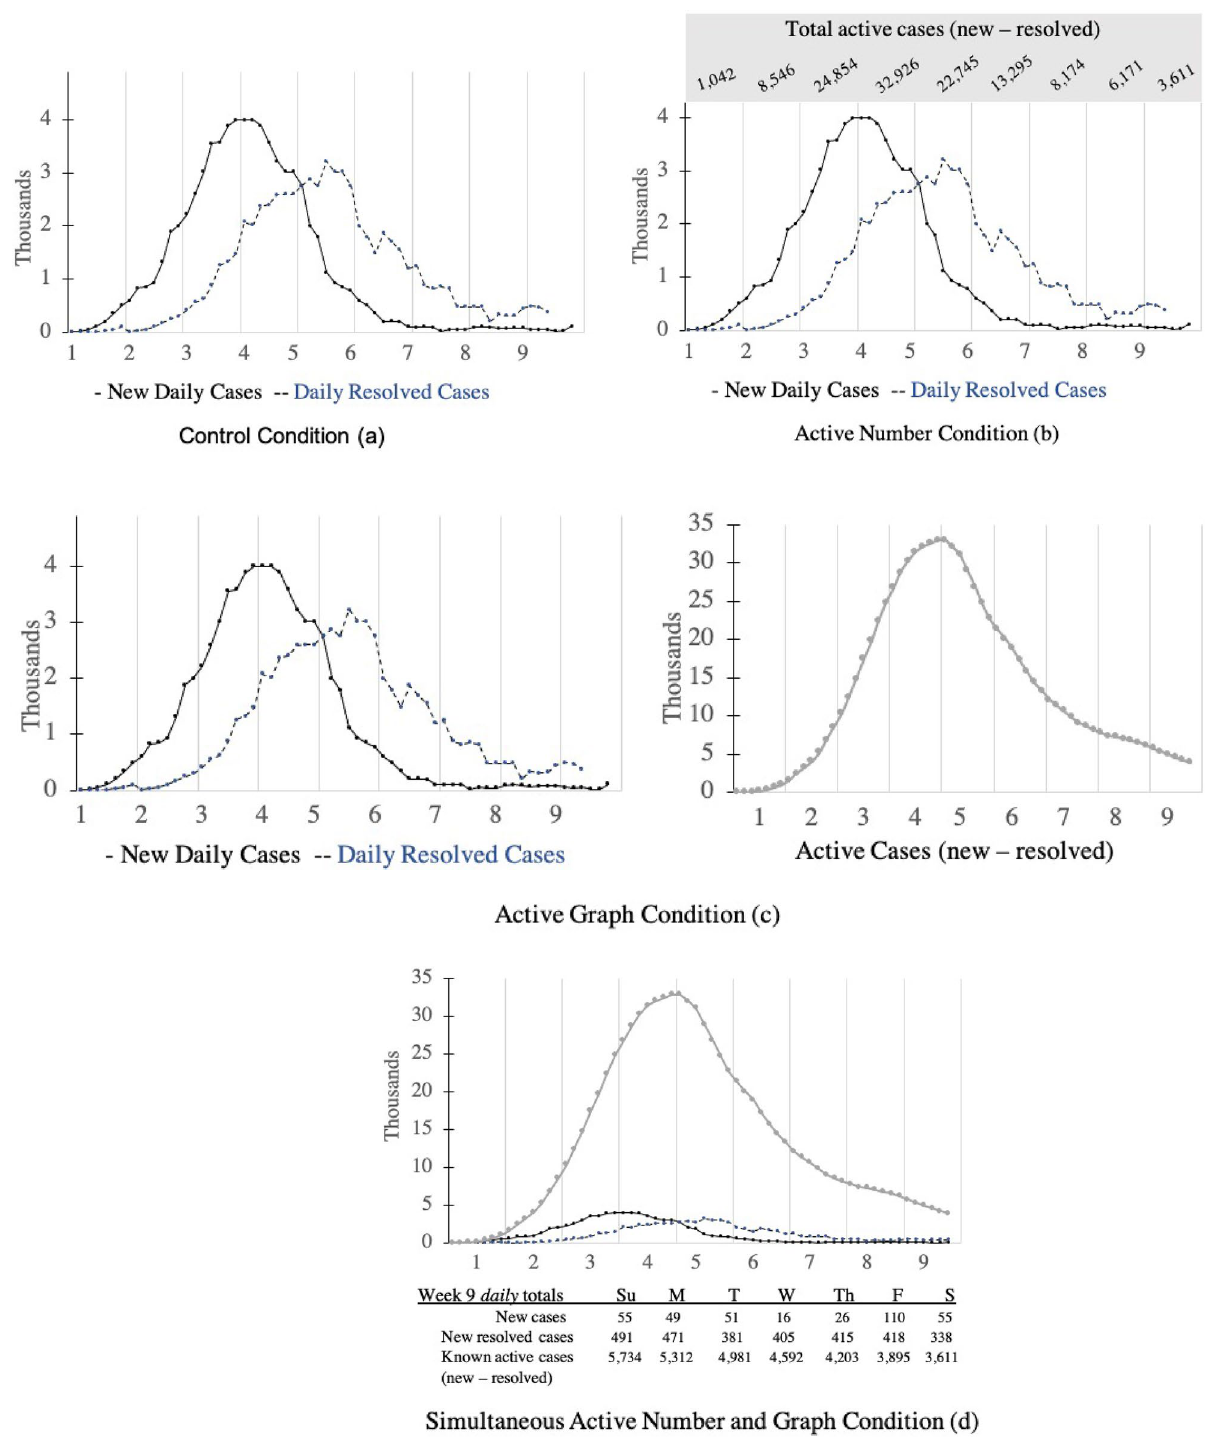
Figure 2. ( a – d ) Visual display of experimental stimuli that participants evaluated. ( a ) Control condition: participants were shown an unfolding graph of new daily cases (black line) and daily resolved cases (blue line). ( b ) Active numbers condition: participants were shown the same unfolding graph as condition and they were also provided with unfolding calculated total active case numbers for each week at the top of the graph. ( c ) Active graph condition: participants were shown two side by side graphs, they were shown the same unfolding graph as condition ( a ) and an unfolding graph of the total active case numbers for each week. ( d ) Simultaneous Active Numbers and Graph Condition: Participants were shown an unfolding graph of new daily cases (black line), new resolved cases (blue line), total active cases (grey line) together as well as a table break down of case numbers for each